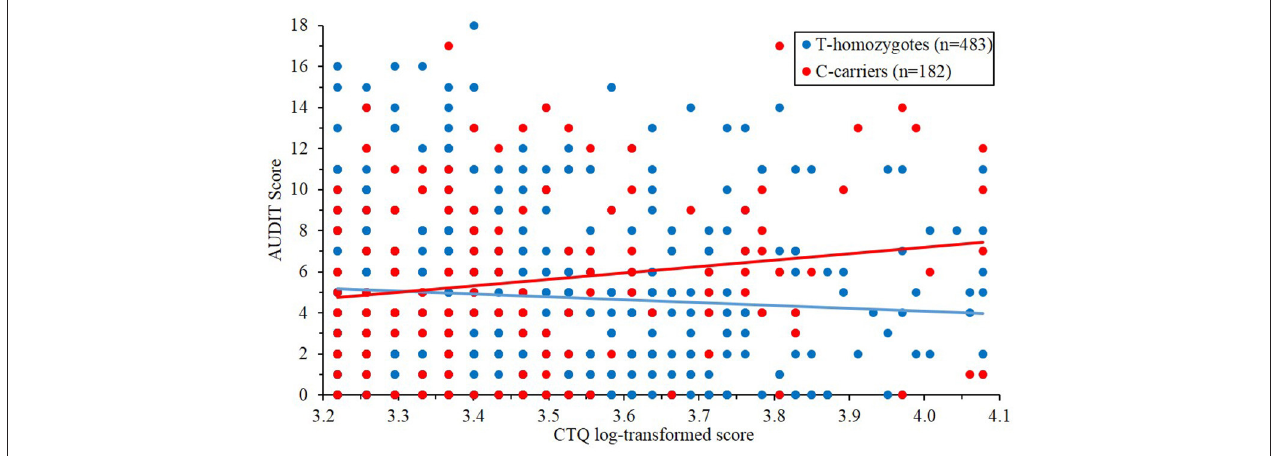
FIGURE 1 | PER1 rs3027172 and early life adversity interact to predict problematic drinking ( 1 R 2 = 0.0106 , β = 0.124, t = 2.86 , p = 0.00438 ). C minor-allele carriers report increased problematic drinking behavior (AUDIT scores) in the context of early life stress (CTQ scores). The purple-shaded region denotes the regions of significance (i.e., CTQ log-transformed > 3.57, equivalent to a score of